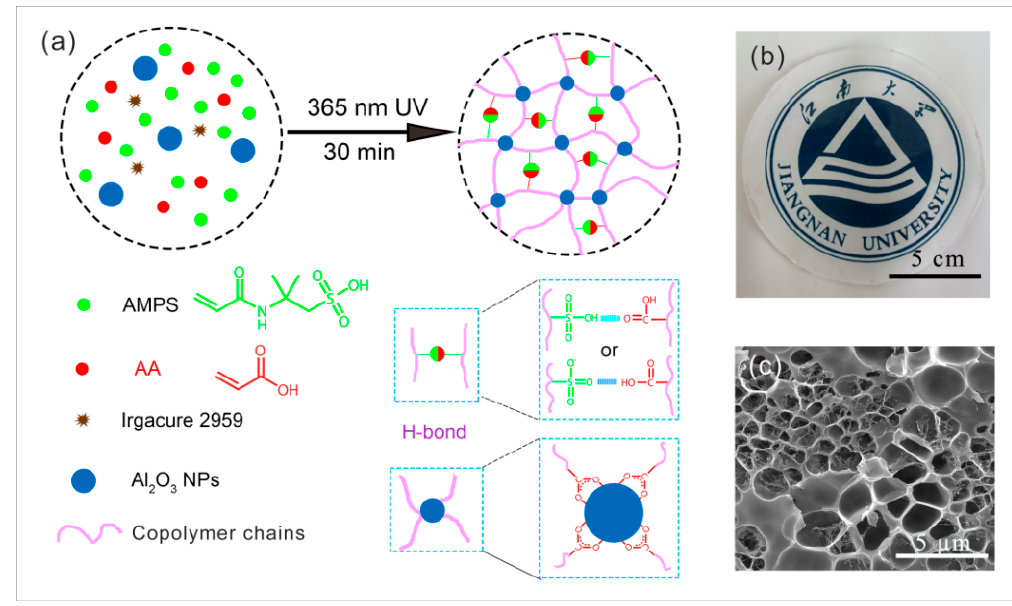
Figure 1. ( a ) Preparation and cross-linking mechanism of poly (AA- co -AMPS)/Al 2 O 3 -nanocomposite hydrogels (PAS gels); ( b ) digital picture of as-prepared PAS gels; ( c ) typical scanning electron microscopy (SEM) image of PAS-6 gel.